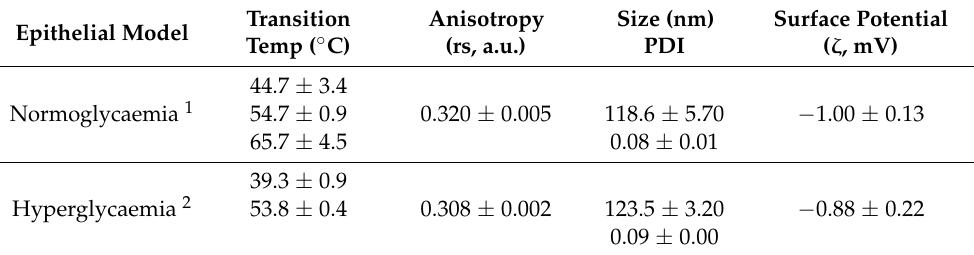
Table 2. Characterisation of the epithelial membrane model under normo- (PC/PE/Chol/GSL) and hyperglycaemic conditions (PC/PE/PE-glyc/Chol/GSL) concerning the mean transition temperatures (t, ◦ C), anisotropy (rs, at 37 ◦ C), size, and surface potential. Values are relative to mean ± SD of independent experiments ( n = 3).